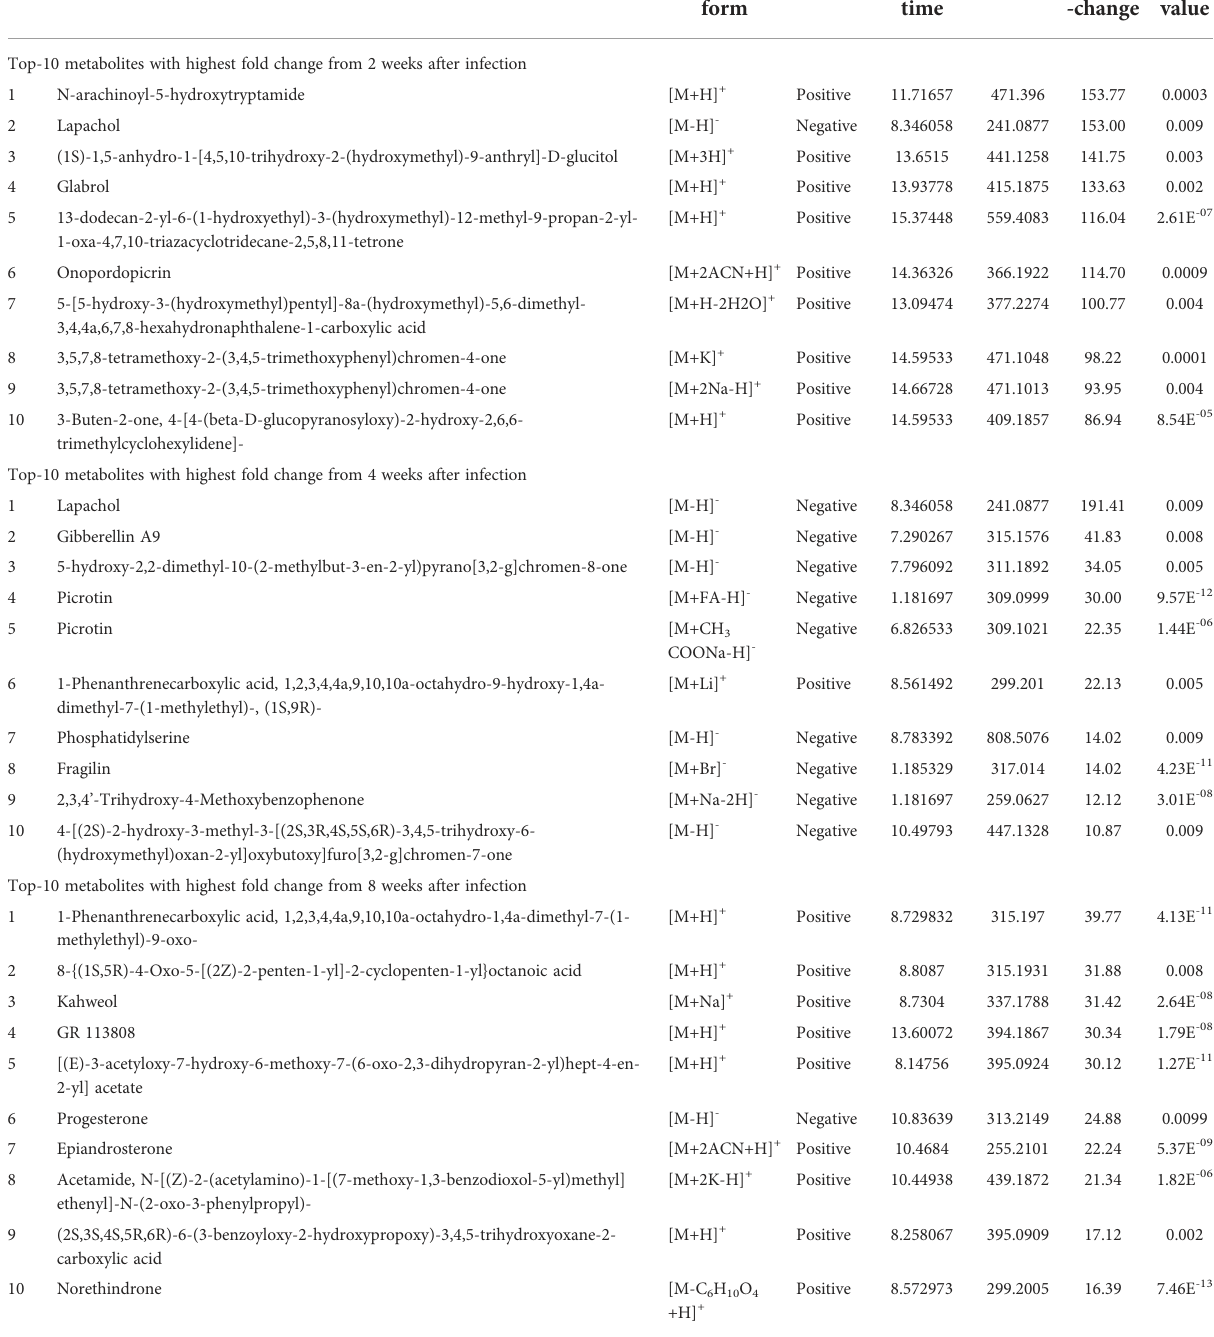
TABLE 1 Top 10 metabolites with the highest fold change at 2, 4, and, 8 weeks after S. mekongi infection.